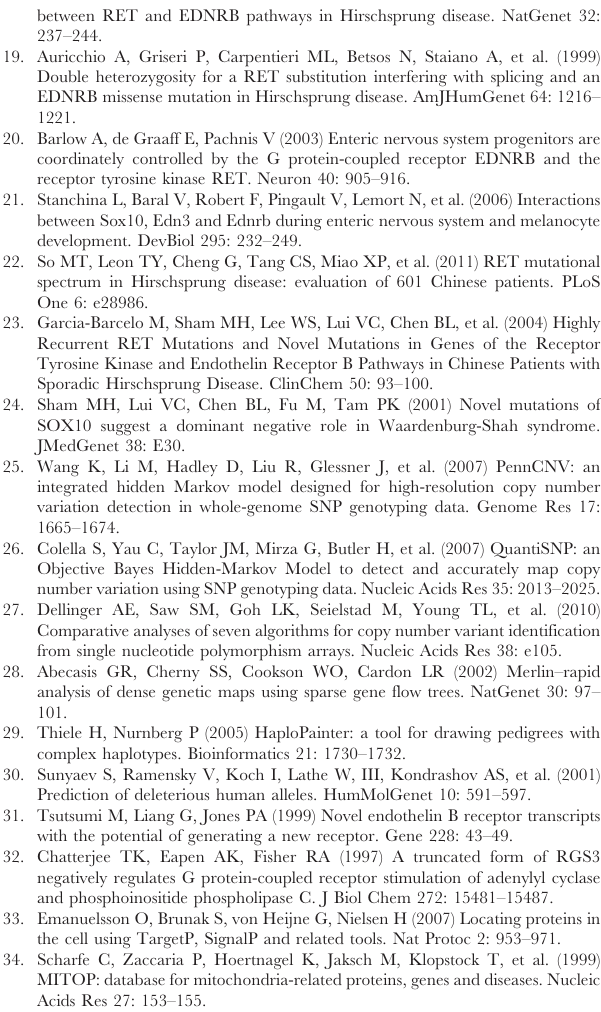
Figure S2 The most likely RET haplotypes of the pedigree (A, C, G, T to 1, 2, 3, 4). Individuals carrying the EDNRB mutation are indicated. Figure S3 The most likely EDN3 haplotypes of the pedigree were shown (A, C, G, T to 1, 2, 3, 4). It showed that the c.-248G/A variation was transmitted from the I-1 and shared by all four affected individuals, II-1, II-3, II-5, and III-3 and one unaffected individual III-4. Figure S4 Nucleic acid multiple sequence alignment of mammalian 5 9 UTR of EDN3 . The UCSC genome browser was used to identify sequence conservation features in the 5 9 UTR of EDN3 . The red rectangle indicates the nucleotide c.-248G and it is highly conserved among species. Figure S5 Predicted RNA secondary structures for the wild-type and mutated (-248G/A) 5 9 UTR of the EDN3 . The GGGGUGGU structure in the mutated 5 9 UTR of the EDN3 formed a loop instead of a stem compared in the wild-type 5 9 UTR of the EDN3 .